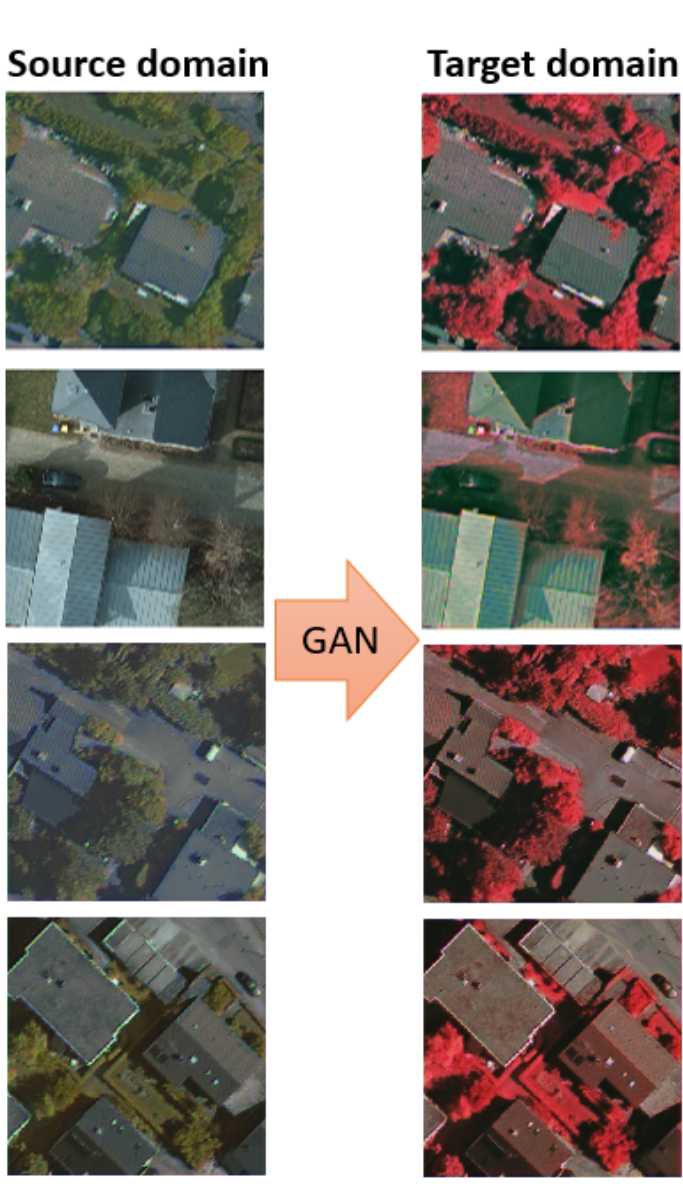
Figure 12. Mapping images from the source domain to the target domain using our proposed